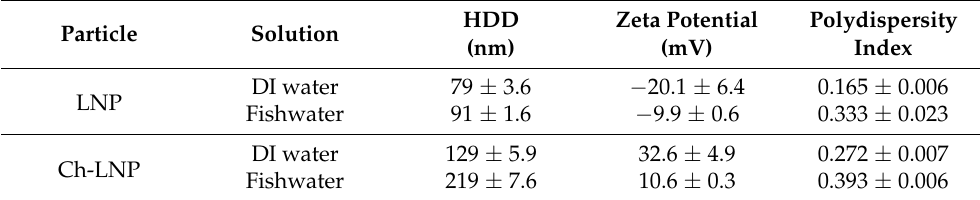
Table 1. Dynamic light scattering (DLS) results showing zeta potential and hydrodynamic diameter (HDD) for the different nanoparticle